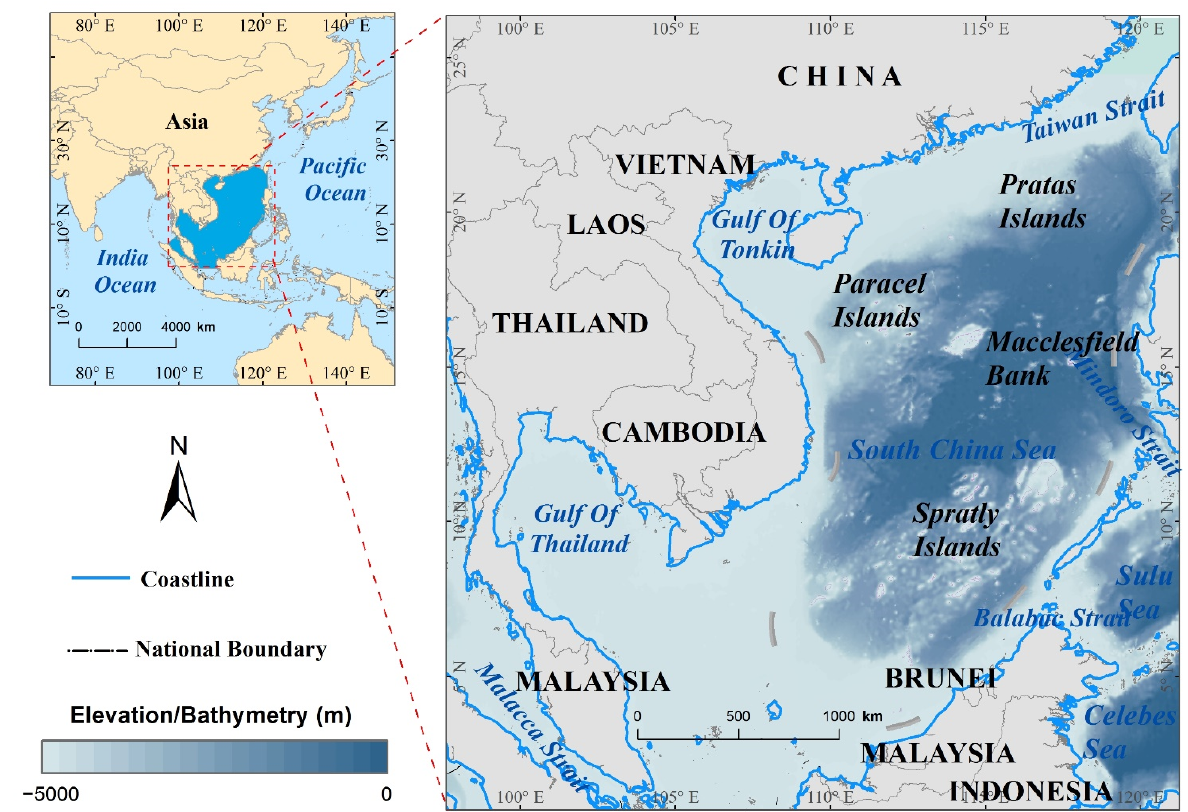
Figure 2. Location map of study area.